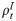
The fraction of diseased individuals ρtI in SIR-IC system as a function of the time t for different values of activation rate κ.κ = 0: diseases information are not taken into account in this case. We fix other parameters as follow: β = 0.3, γ = 0.2 (λ = 1.5), N = 1000.